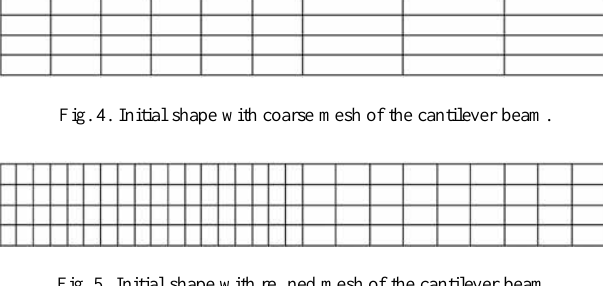
Fig. 5. Initial shape with refined mesh of the cantilever